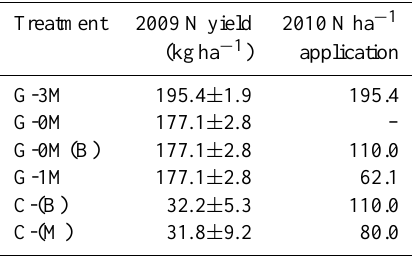
Table 6. Cumulative N yield (kgha − 1 ) in harvested biomass during the study period in 2009 (GM-year). Values given are the mean of 4 replicates plots ± standard deviation. In 2009, G-0M, G-0M(B) and G-1M were treated identically until the last harvest; there- fore, composite samples for N analysis were taken from these treat- ments. In 2010, only biogas residue (containing 60 kg NH + 50kgorganicNha − 1 ) and mineral fertiliser was applied in corre- sponding treatments and it is assumed that all N applied as GM mulch during the previous year to G-3M and G-1M was carried over to the cereal cropping